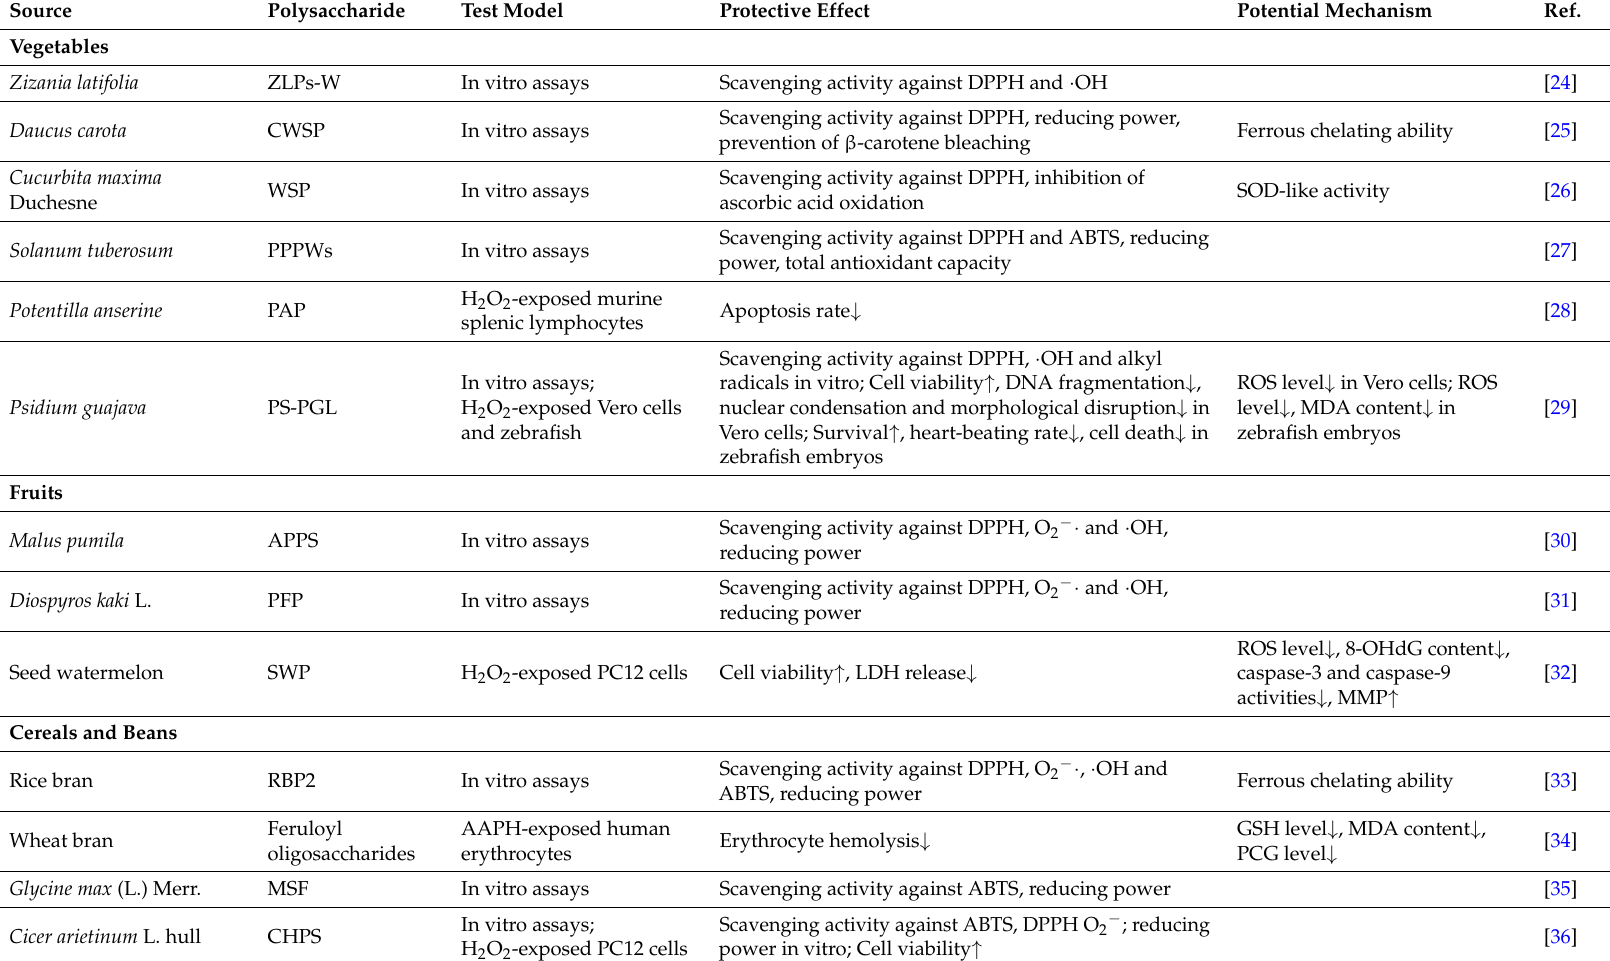
Table 1. The antioxidant activities and mechanisms of food-derived